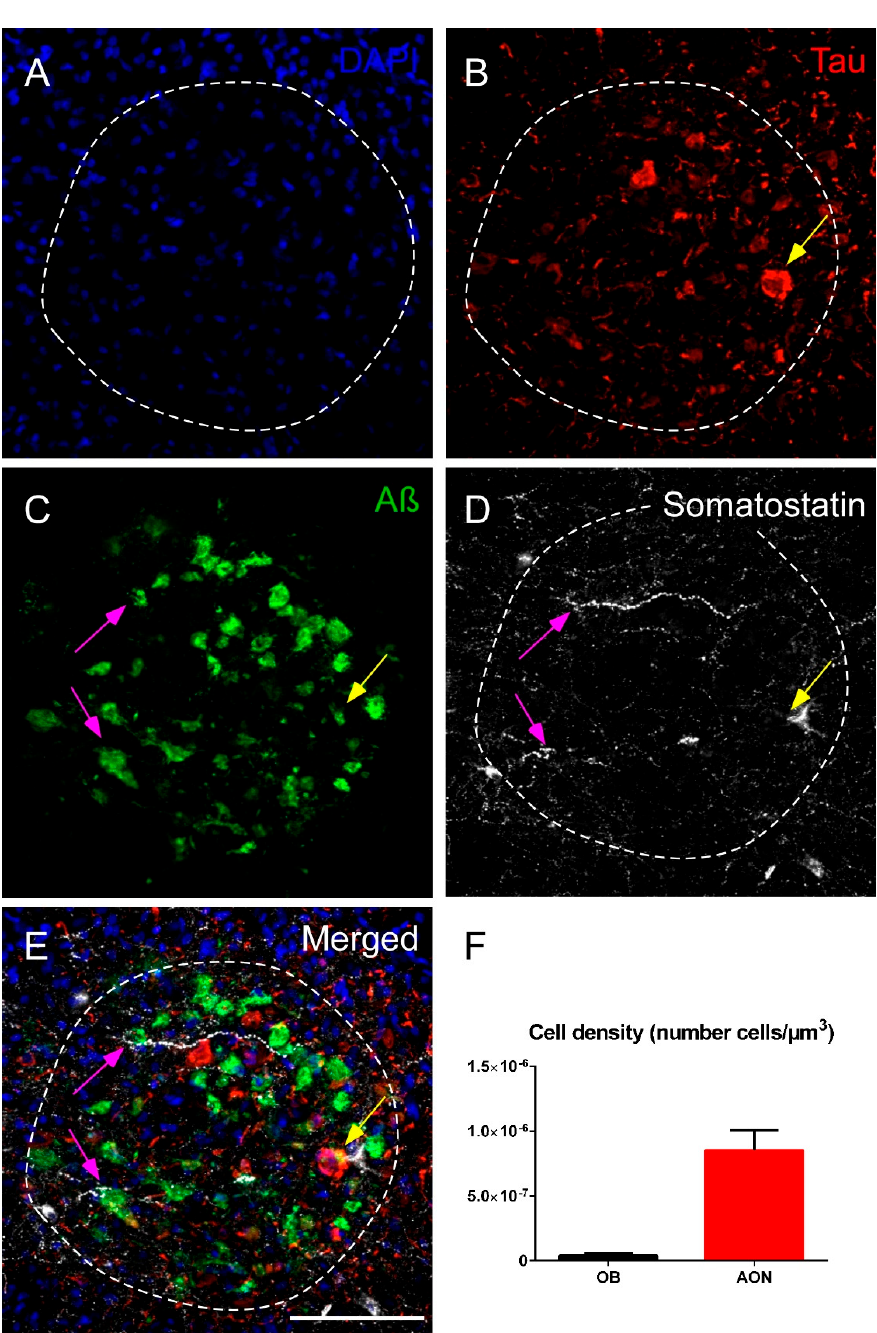
Figure 5. Immunofluorescence staining of somatostatin, tau and amyloid- β in the human olfactory bulb in AD. Representative images show DAPI staining in the anterior olfactory nucleus ( A ), tau ( B ), amyloid- β ( C ) and somatostatin ( D ). Note the elevated expression of amyloid- β and somatostatin and the preferential coexpression of both markers (purple arrows) or, less commonly, the coexpression of the three markers (yellow arrow) ( E ). The cell density indicates that the anterior olfactory nucleus is the main area in the olfactory bulb that expresses somatostatin ( F ). sp, stratum piramidale; sm, stratum moleculare. Scale bar A – E 100 µm.